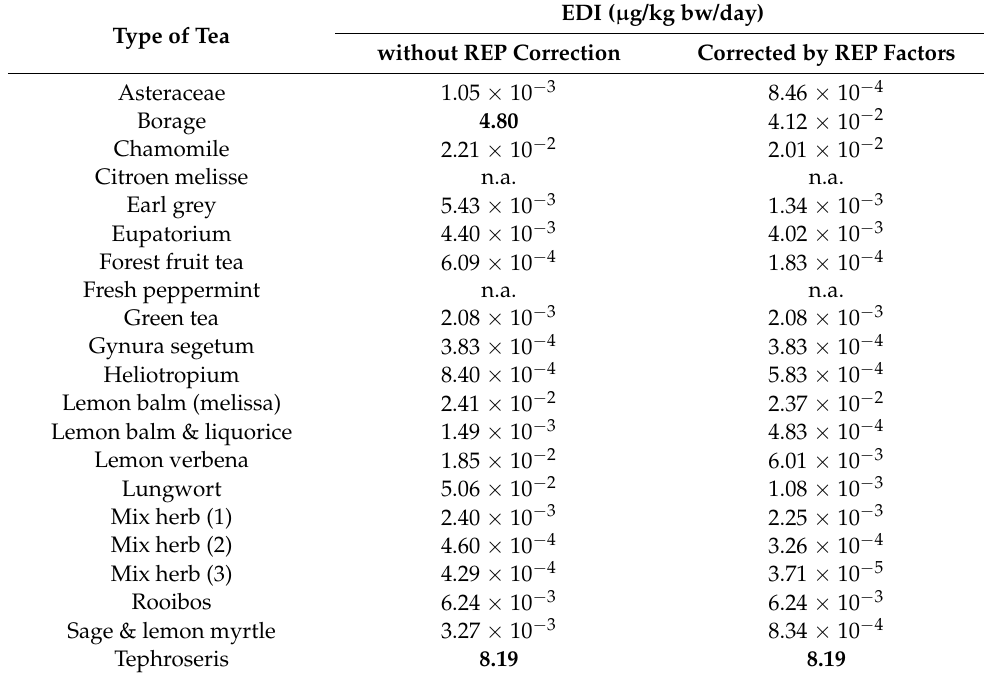
Table 3. The EDIs for 21 types of (herbal) teas based on PA levels with or without REP correction. Type of